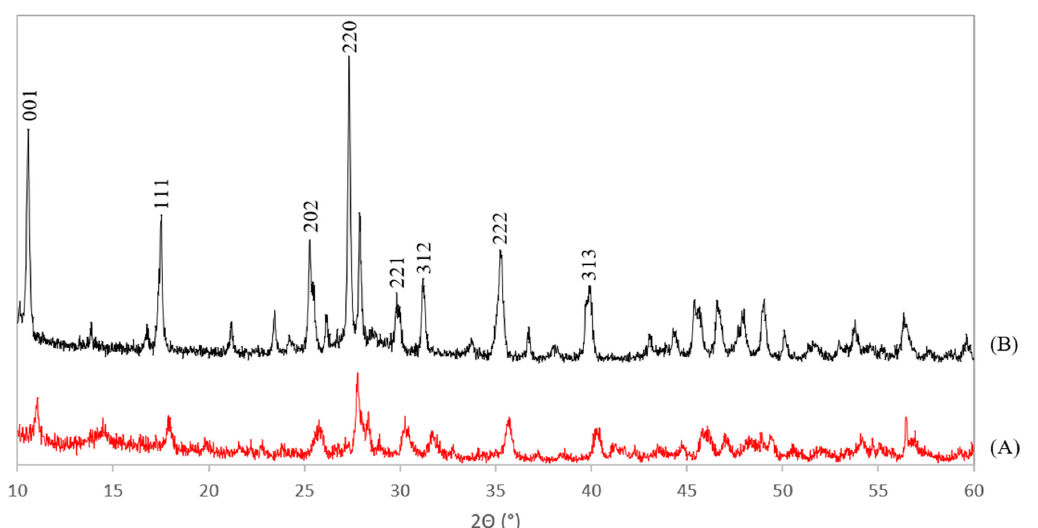
Figure 3. XRD patterns of the benchmark scale Ce-LDH ( A ) and the scaled-up Ce-LDH with Miller indices appointed to the reflections ( B ). Table 1. Cell parameters of the orthorhombic lattice of the Ce-LDH and scaled-up Ce-LDH.